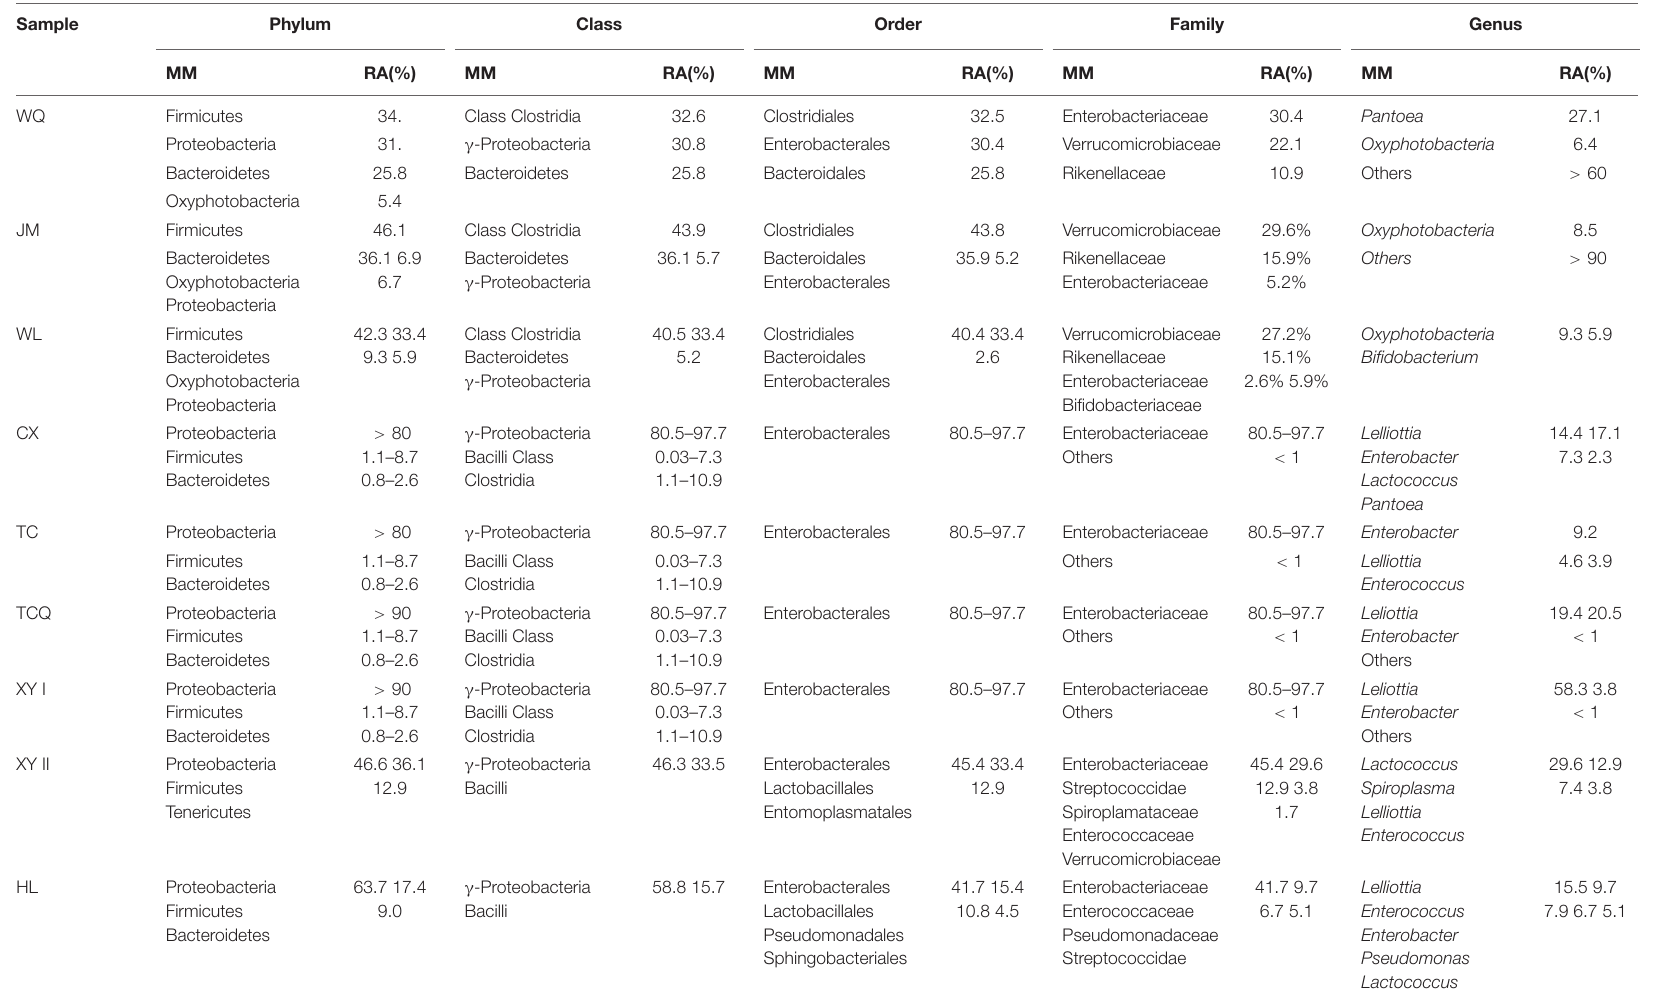
TABLE 3 | The major microorganisms (MM) and their relative abundance (RA) of five taxonomic levels of L. decemlineata nine samples. Sample